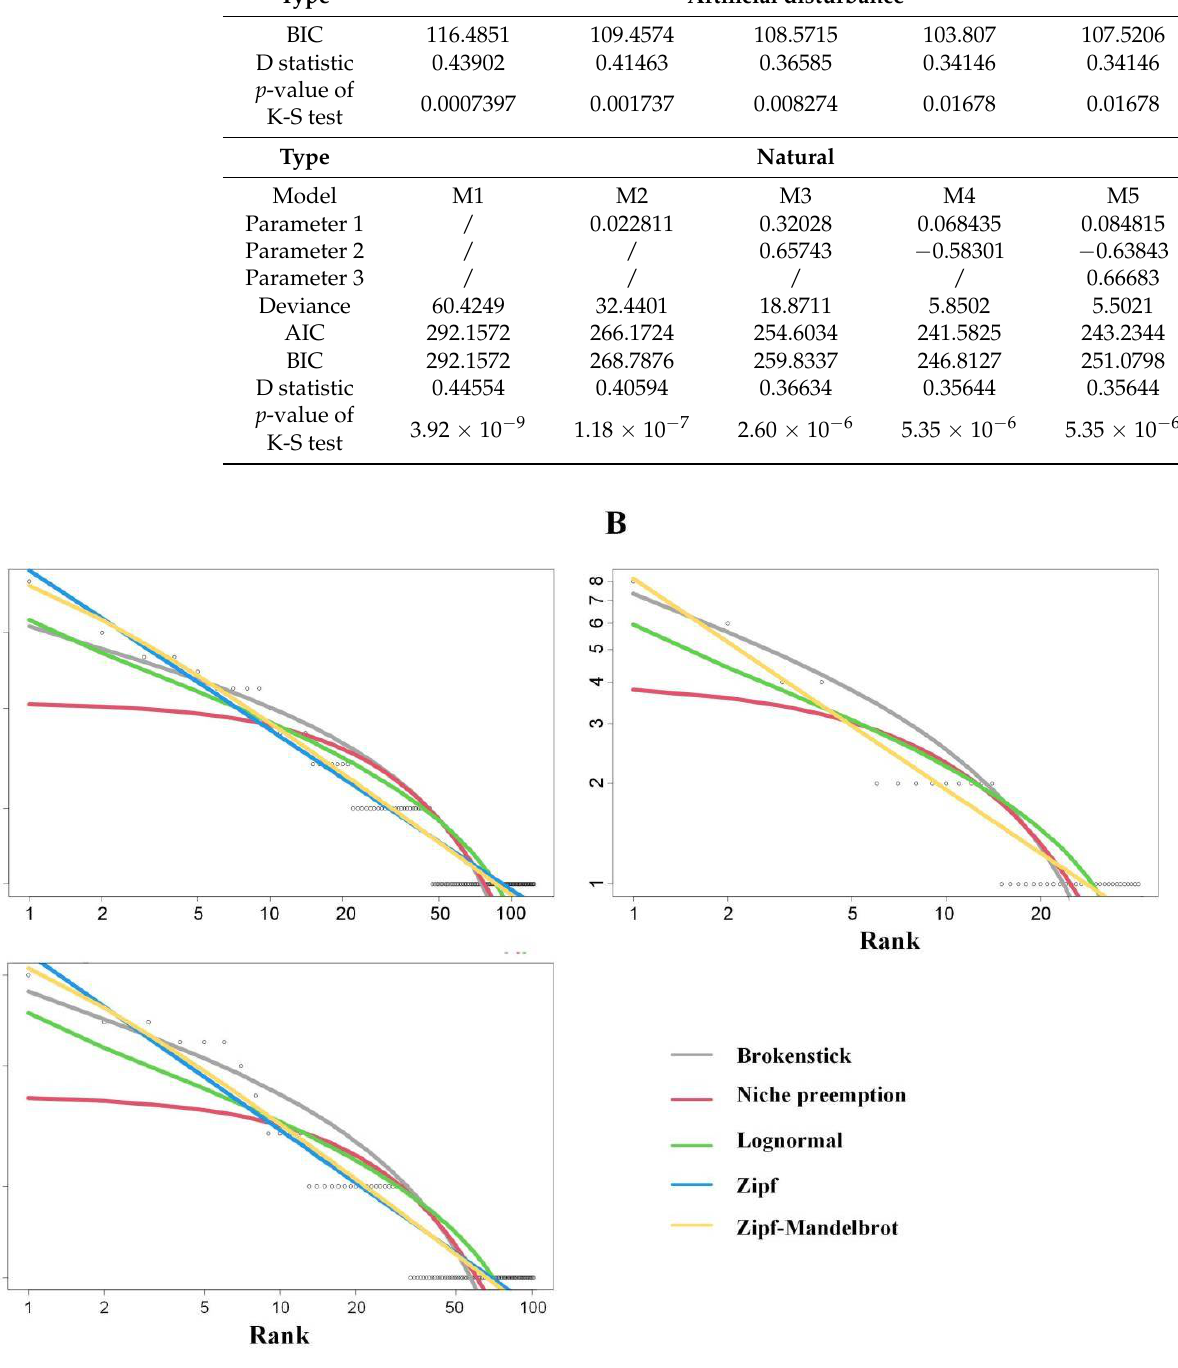
Figure 3. Fitting plots of different SAD models. ( A – C ) represents all, artificial disturbance, and natural plots (M1–M5 represent broken stick, niche preemption, log normal, Zipf, and Zipf–Mandelbrot).